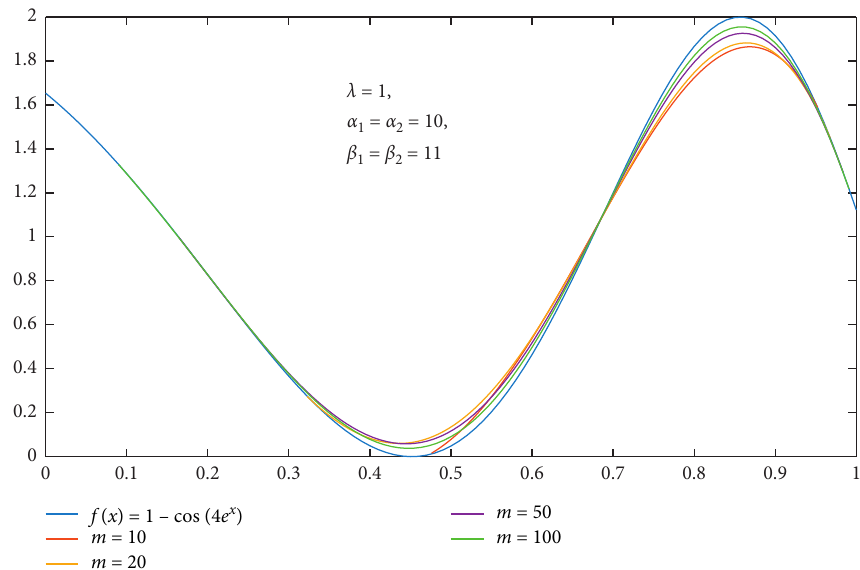
Figure 4: Convergence of G 10 , 11